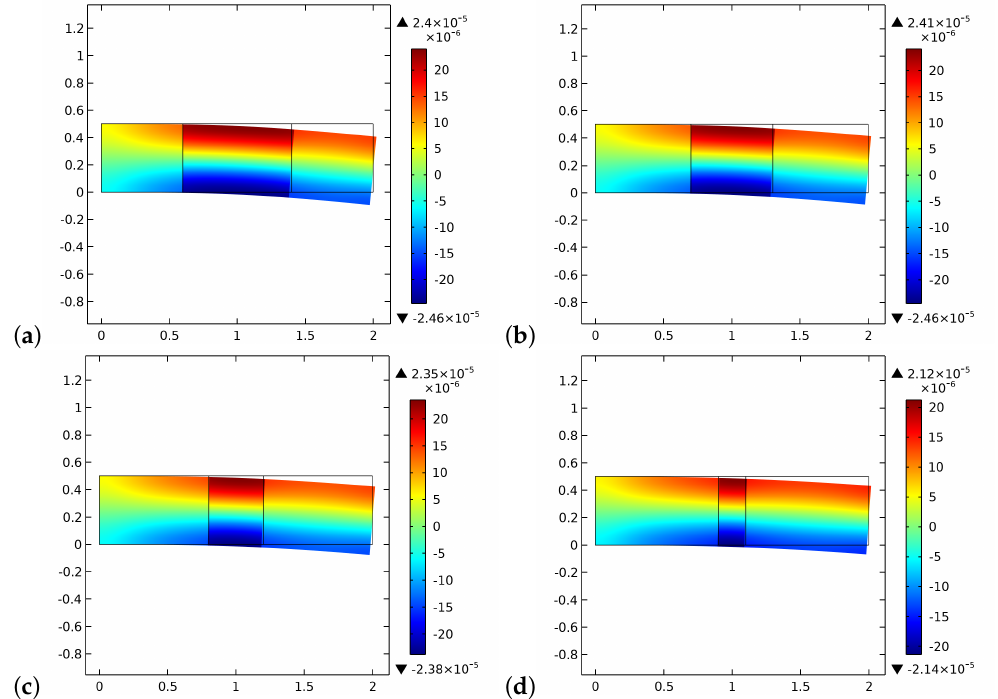
Figure 7. The distribution of ζ at the end of the time of simulation for different substitute lengths of the graft: ( a ) 0.8 cm. ( b ) 0.6 cm. ( c ) 0.4 cm. ( d ) 0.2 cm.